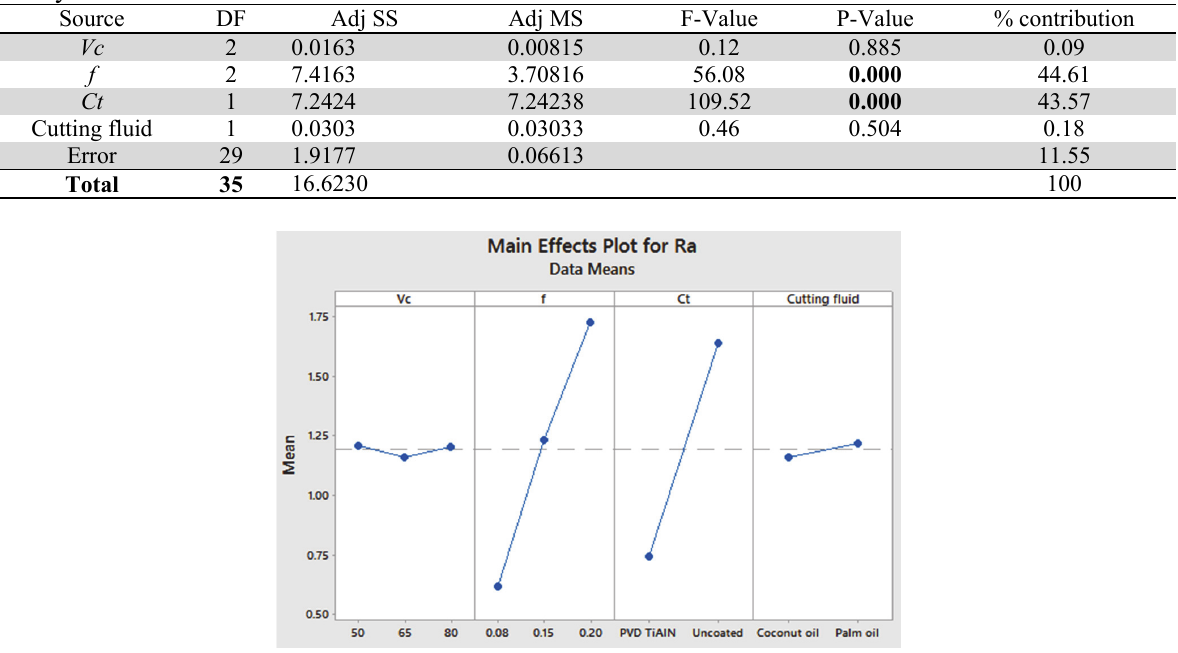
Fig. 6. Main effect plot for Flank wear, Ra (µm)